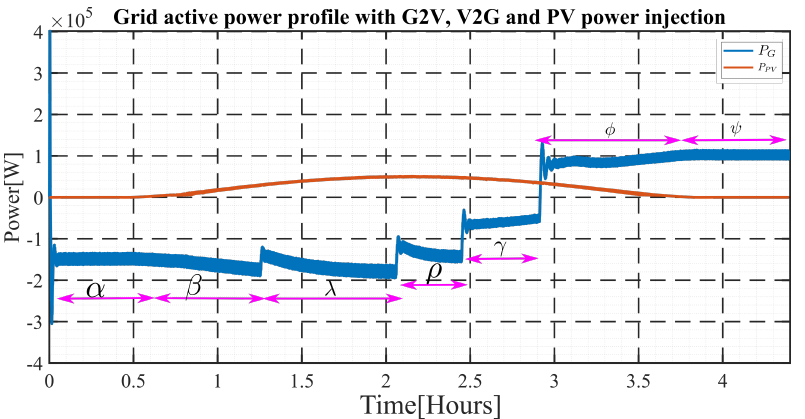
Figure 25. Grid active power profile with the PV power injection, G2V and V2G illustration. Hence, the power flow direction at the point of common coupling is negative at the beginning; it continues to be negative, as the EVs gradually switch back to charging mode following the sequence shown in Table 2. After that, all of the EVs switched to charging, except EV0, which does not change the state; the power demand from the grid is higher than that injected. Therefore, the grid power becomes positive, as the grid is giving power. During that process, the grid power is intelligently supported by the PV power until the last goes completely off. Therefore, the grid has to fully charge the rest of the EVs supported partially by the